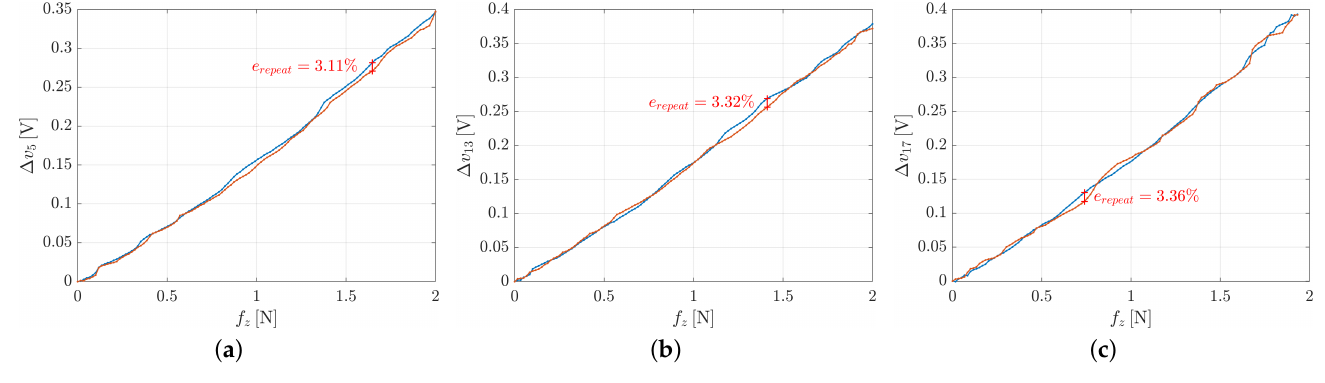
Figure 11. Repeatability error graphs for taxel 5 ( a ), taxel 13 ( b ) and taxel 17 ( c